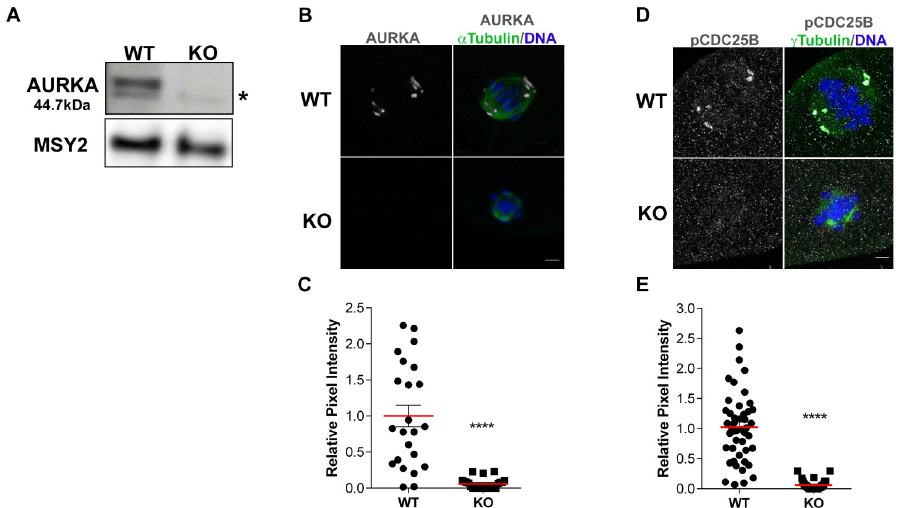
Fig 1. AURKA is deleted from oocytes. (A) Western blot detecting AURKA from prophase-I arrested wild-type (WT) and Aurka knockout (KO) oocytes (100 oocytes/lane). After stripping the membrane, MSY2 served as loading control. n = 4 animals/genotype/experiment. Asterisk = non-specific band (B-E) Localization and activity of AURKA in WT and KO oocytes. (B) Representative confocal images of metaphase I oocytes immunostained with antibodies against AURKA (gray), α -Tubulin (green) and DAPI (blue) (C) Quantification of AURKA intensity in (B); (Unpaired Student’s t-Test, two-tailed, ���� p < 0.0001; number of oocytes, WT: 23; KO: 24) (D) Representative confocal images of metaphase I oocytes immunostained with antibodies against phosphorylated CDC25B (gray; pCDC25B), γ -Tubulin (green) and DAPI (blue). (E) Quantification of pCDC25B intensity in (D); (Unpaired Students t-Test, two-tailed, ���� p < 0.0001; number of oocytes, WT: 46; KO: 30). Graphs show individual oocyte values plus the mean ± SEM from 2–3 independent experiments. Scale bars: 10 μ m.